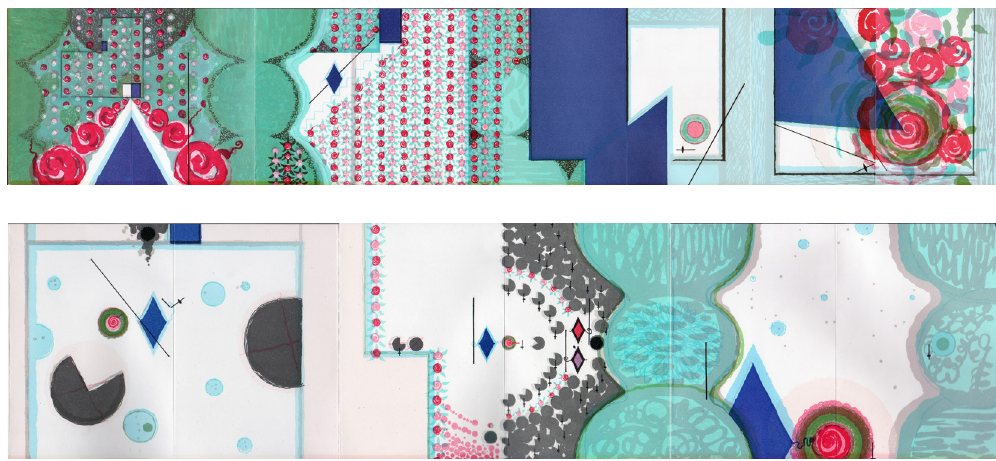
Fig. 19 Warja Lavater, The third prince approaches the castle ; the prince climbs the stairs ; the prince enters the attic and bows to Belle ; the prince kisses Belle and brings her back to life . Warja Lavater (1982). La Belle au Bois Dormant. Paris : Maeght éditeur (above). Fig. 20 Warja Lavater, The prince breaks the cursed spindle introduces himself to the royals ; the prince marries Belle ; the prince and Belle leave the castle . Warja Lavater (1982). La Belle au Bois Dormant . Paris: Maeght